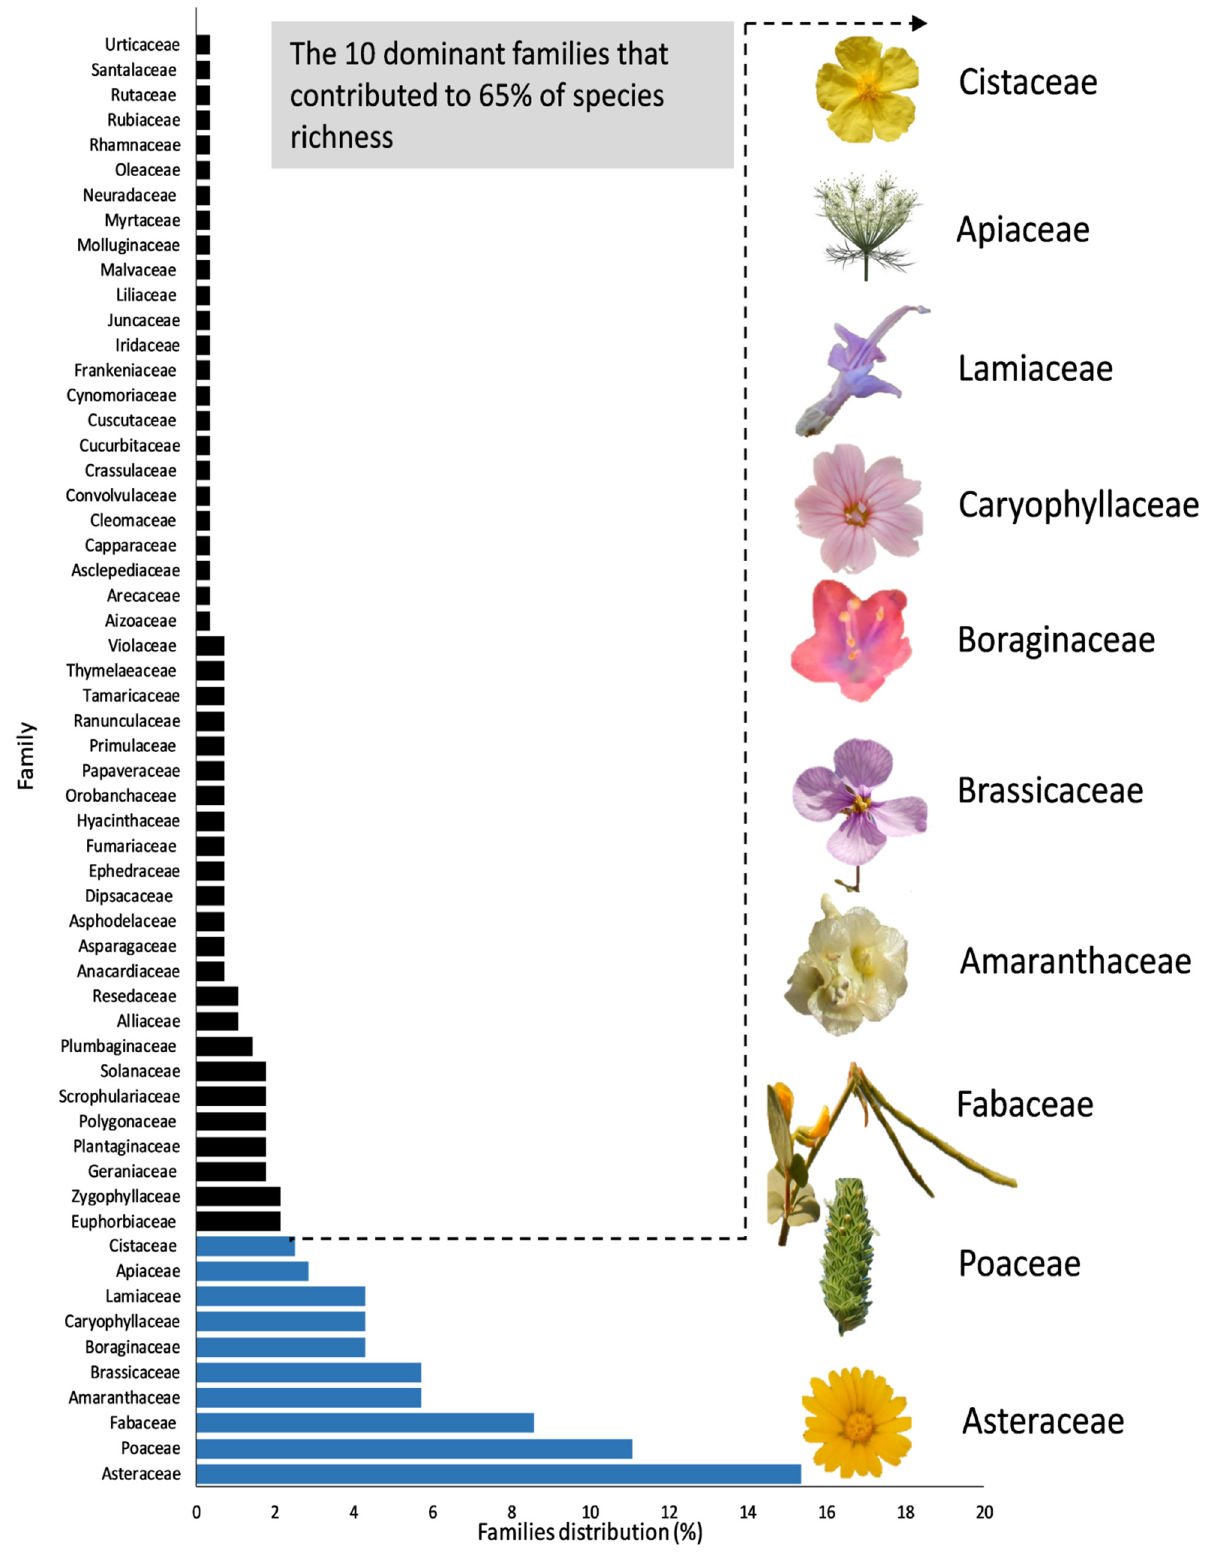
Figure 3. Plant family diversity in the arid and desert rangelands of Tataouine, Tunisia (spring 2018). Overall, 54% of the species were annual (150 species) and 46% were perennial (130). Several annual plant species can be found exclusively in improved microsite conditions (e.g., lower temperatures, reduced solar radiation, or increased organic matter) in rocky